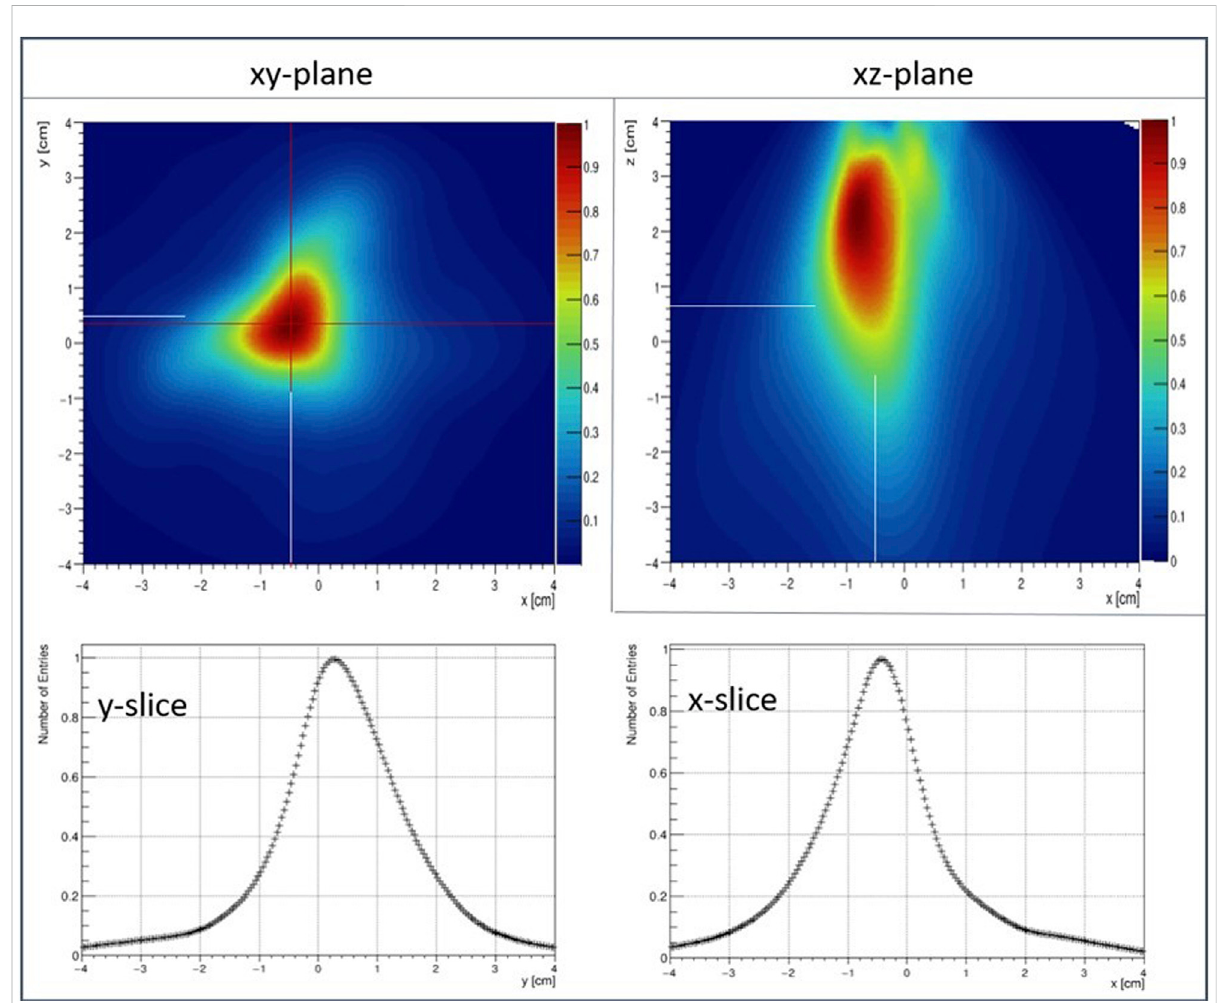
FIGURE 7 Pointspreadfunctionsofa 22 Napointsourceplacedatx= − 5 mm,y=5 mmandz=5 mmreconstructedinCompton-onlymode(toprow)and a slice through one bin (indicated by the red lines) along the two respective dimensions (central, bottom row). The intersection of the (extrapolated) white lines indicates the actual source